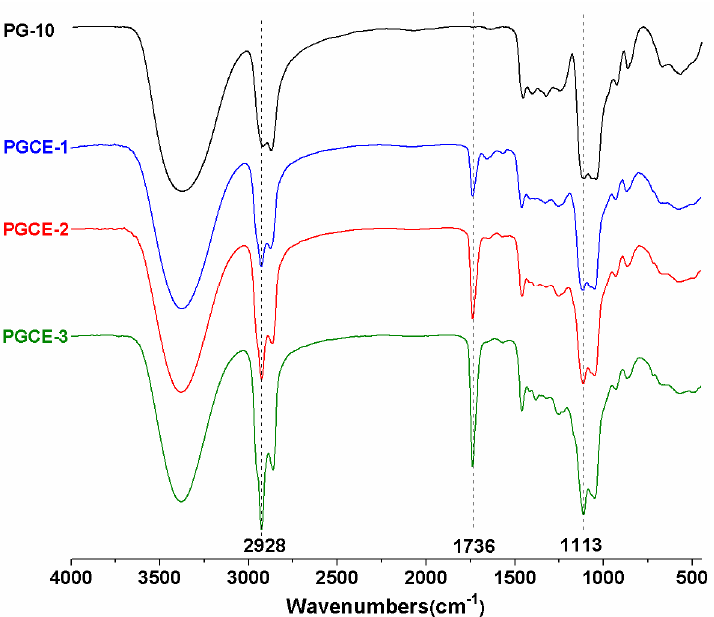
Figure 1. Fourier transformed infrared (FTIR) spectra of polyglycerin-10 (PG-10) and polyglyceryl-10 caprylates (PGCE) in KBr.